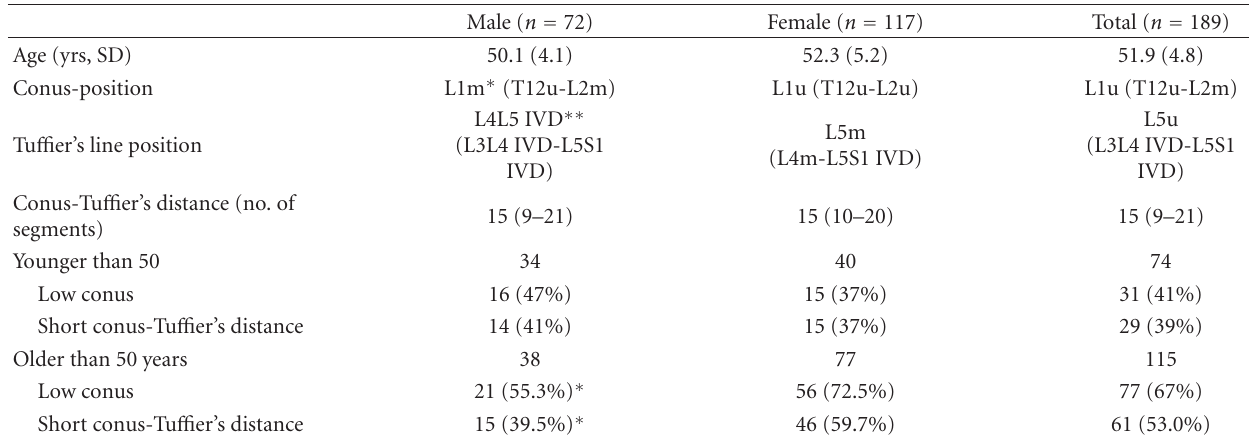
Table 1: Primary characteristics of